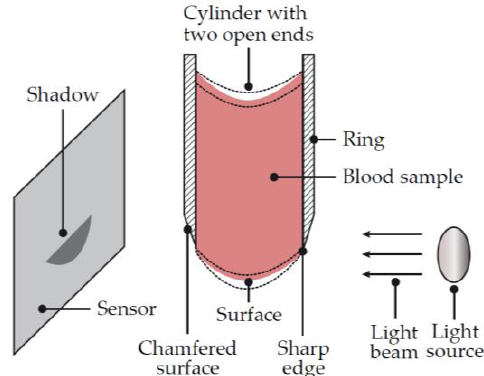
Figure 8. Schematic representation of the TEG ® 6s. The diameter of the ring and cylinder is sized to allow the blood sample to be held within the cylinder by surface tension, without support at the bottom surface. The light source (light emitting diode) directs a beam of light at the blood sample, casting a shadow on the sensor. As the surface of the sample is excited by the light beam, the sample oscillates and the corresponding shadow becomes larger or smaller depending upon the elasticity of the blood sample. The resonant frequency of the blood sample is determined before, during and after coagulation. Changes in the resonant frequency of the sample are indicative of the hemostasis characteristics of the blood sample. Adapted from US Patent 7,879,615 B2 [24] .